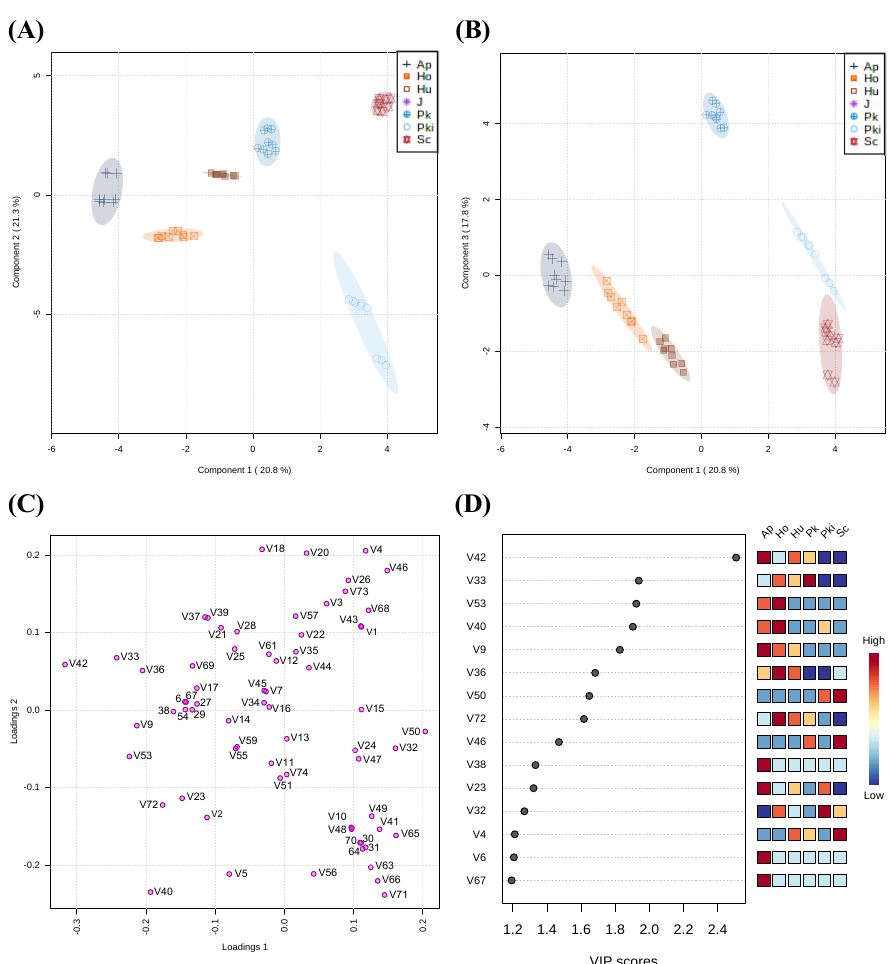
Figure 7. Partial least squares discriminant analysis (PLS-DA) performed on volatile compounds in inoculated fermentations Figure 7. PLS-DA scores plot (A and B) of the variables with by candidate yeast strains. ( A , B ) Score plots demonstrated a clear separation between inoculated fermentations and the component 1, 2 and 3 based on the volatile composition of sterile variables could be explained with three components. Each symbol represents a yeast strain and ellipse around symbols juice (eight spoked asterisk) and inoculated fermentations; represents at 95% confidence region of biological and technical triplicates. ( C ) Variables in loading plot of the components loading plot (C) of the component 1 and 2; and important 1 and 2, and ( D ) selected compounds as important features based on variable important in projection (VIP) scores. The features (D) represented by Variable Important in Projection colored boxes on the right indicate the relative concentrations of the corresponding volatiles in each group with red (high) (VIP) score above 1.2. and blue Each symbol in panel A and B represents a yeast strain, ellipse around symbols represent triplicate samples…… Higher VIP scores indicate….red (high) and blue (low) represent….Confidence region was displayed at 95% confidence level.